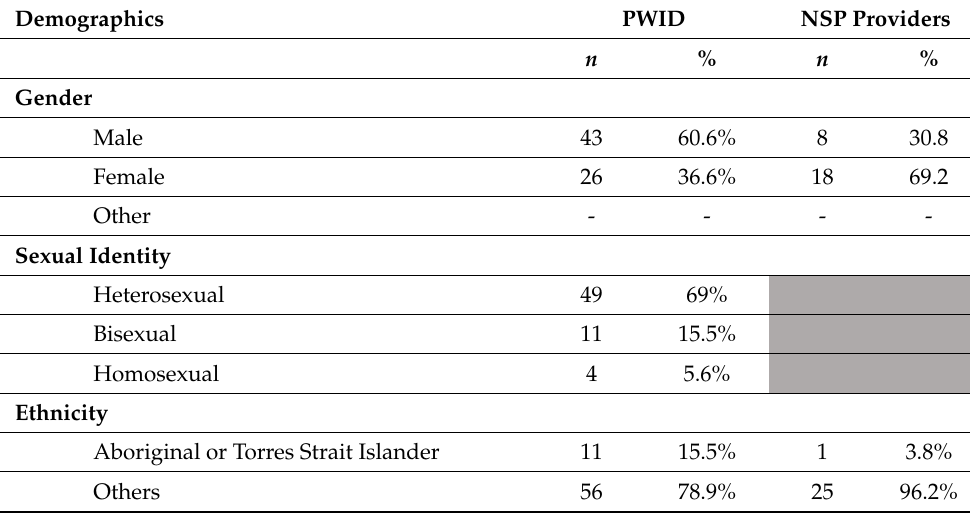
Table 1. Demographics of PWID and NSP Provider